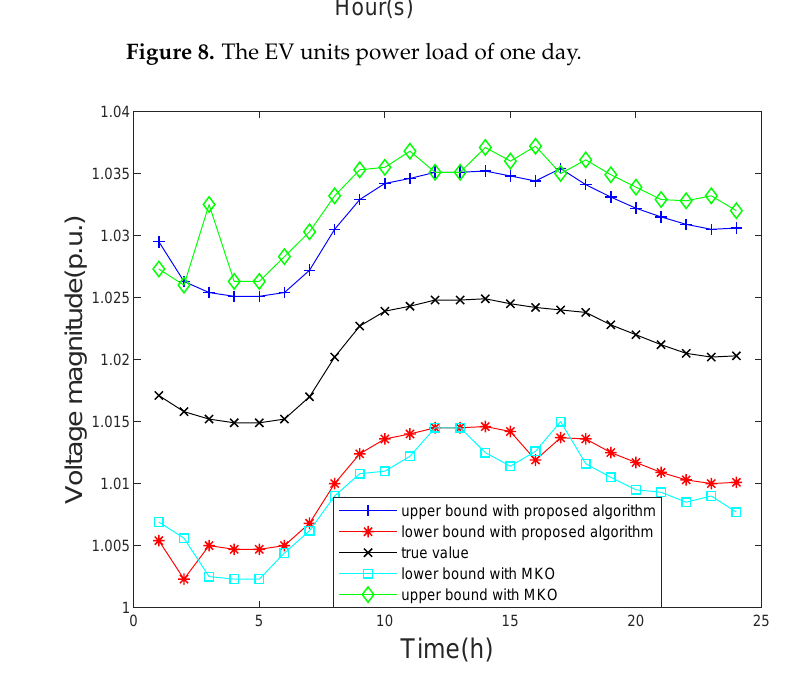
Figure 9. The daily variation of bus voltage magnitude consider EV